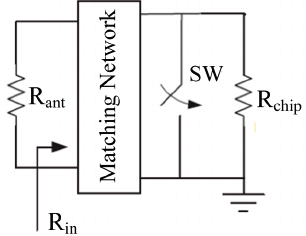
Figure 2. ASK backscattering